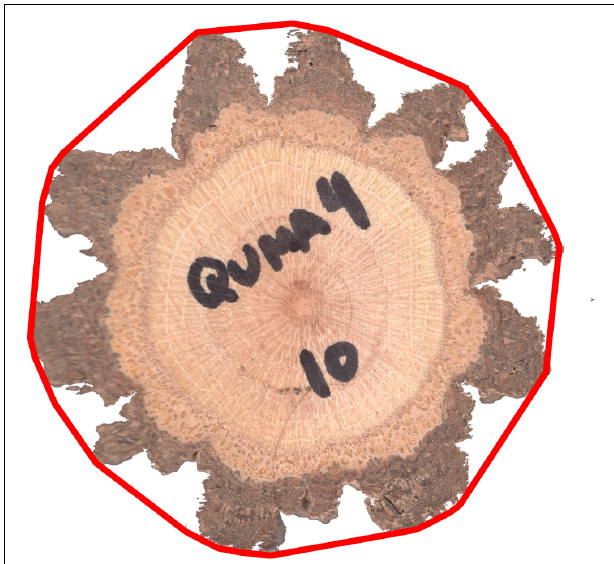
FIGURE 2 | Bark rugosity of a cross-section, in this case a sample of Quercus marilandica at 10 cm height, can be measured as the compliment of the ratio of the cross-sectional area (area of the actual sample) to the area of its convex hull (red line).